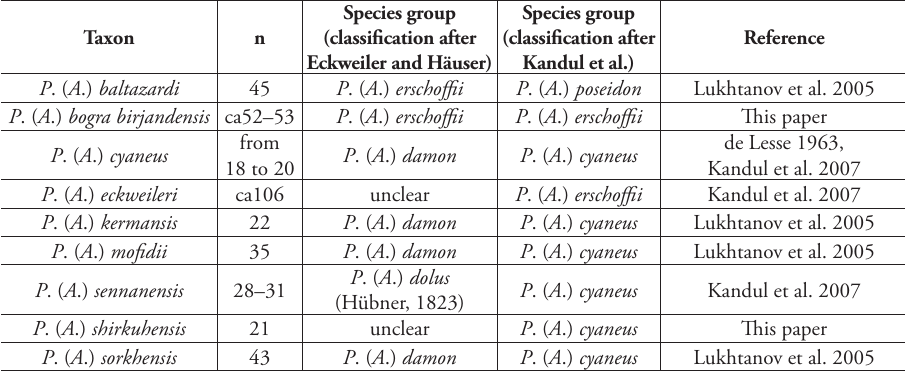
Table 1. Haploid chromosome number (n) of the taxa discussed and the species groups to which these taxa belong in classifications by Eckweiler and Häuser (1997) and Kandul et al.